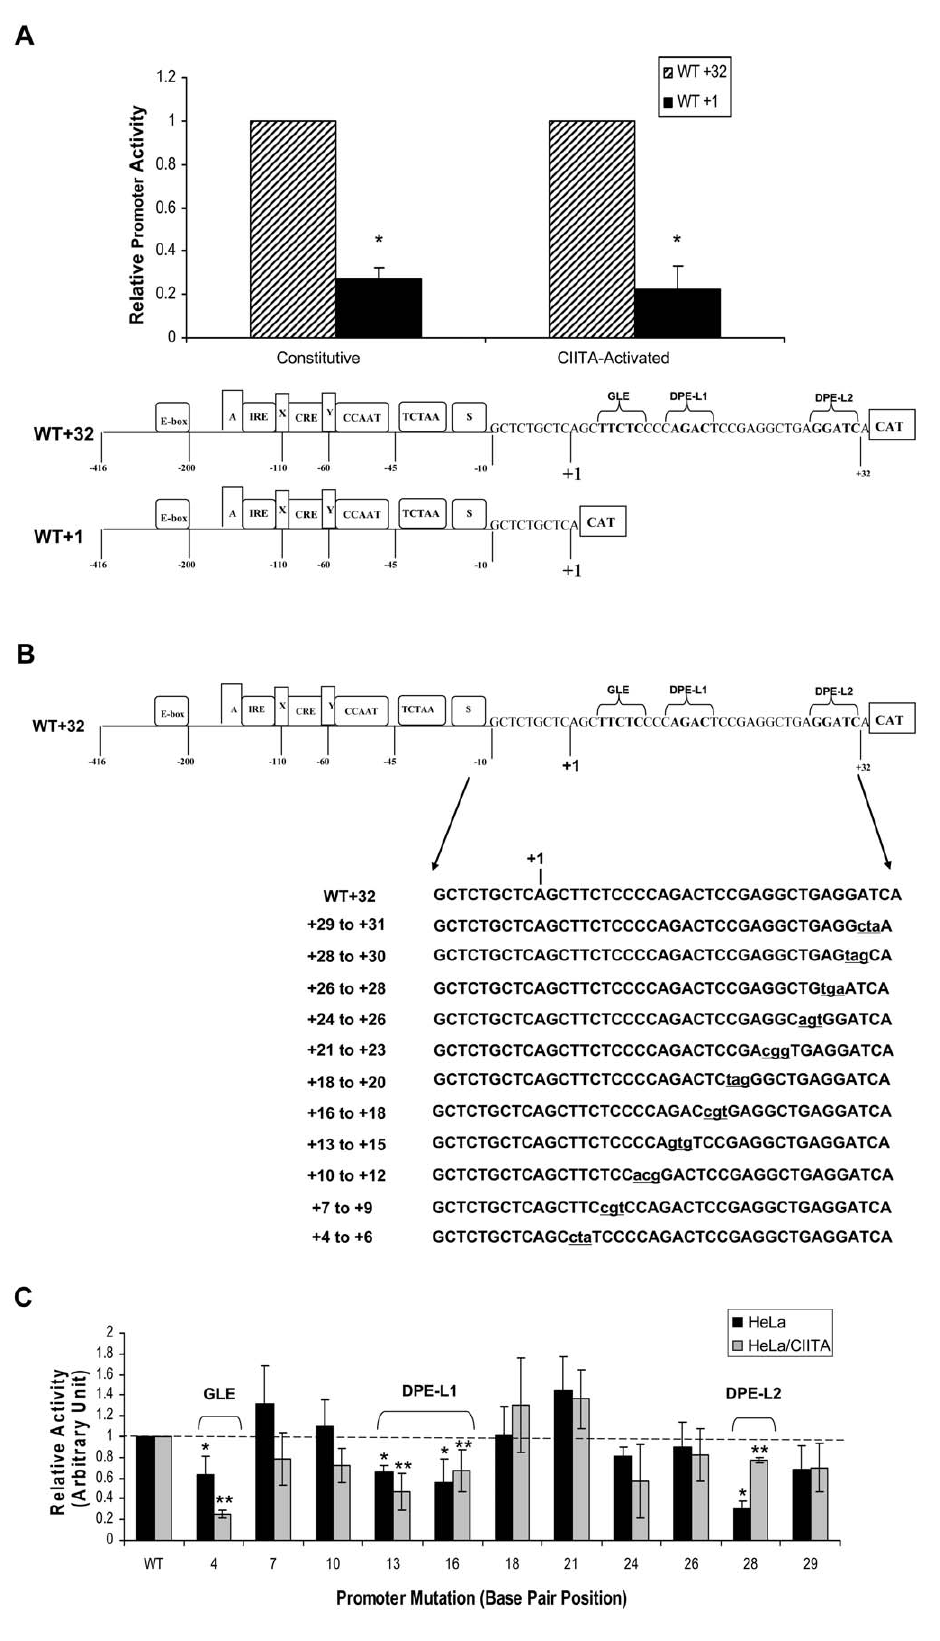
Figure 2. Three downstream elements reside in the downstream region of the MHC class I promoter. A) Sequences downstream of + 1 regulate class I promoter activity in both constitutive and activated transcription. CAT reporter constructs (5 ug) extending from 2 416 bp to either + 1 (WT + 1) to or + 32 bp, (WT + 32) (see diagram) were transfected into either HeLa cells or HeLa/CIITA cells that stably express CIITA.